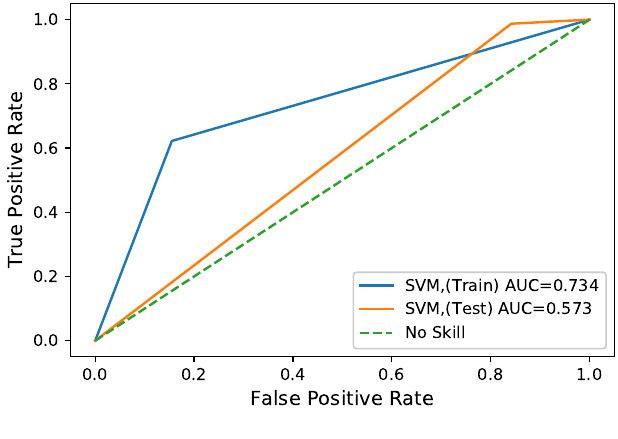
Figure 9. ROC-AUC of the SVM model. Table 11. Confusion matrix values of the SVM